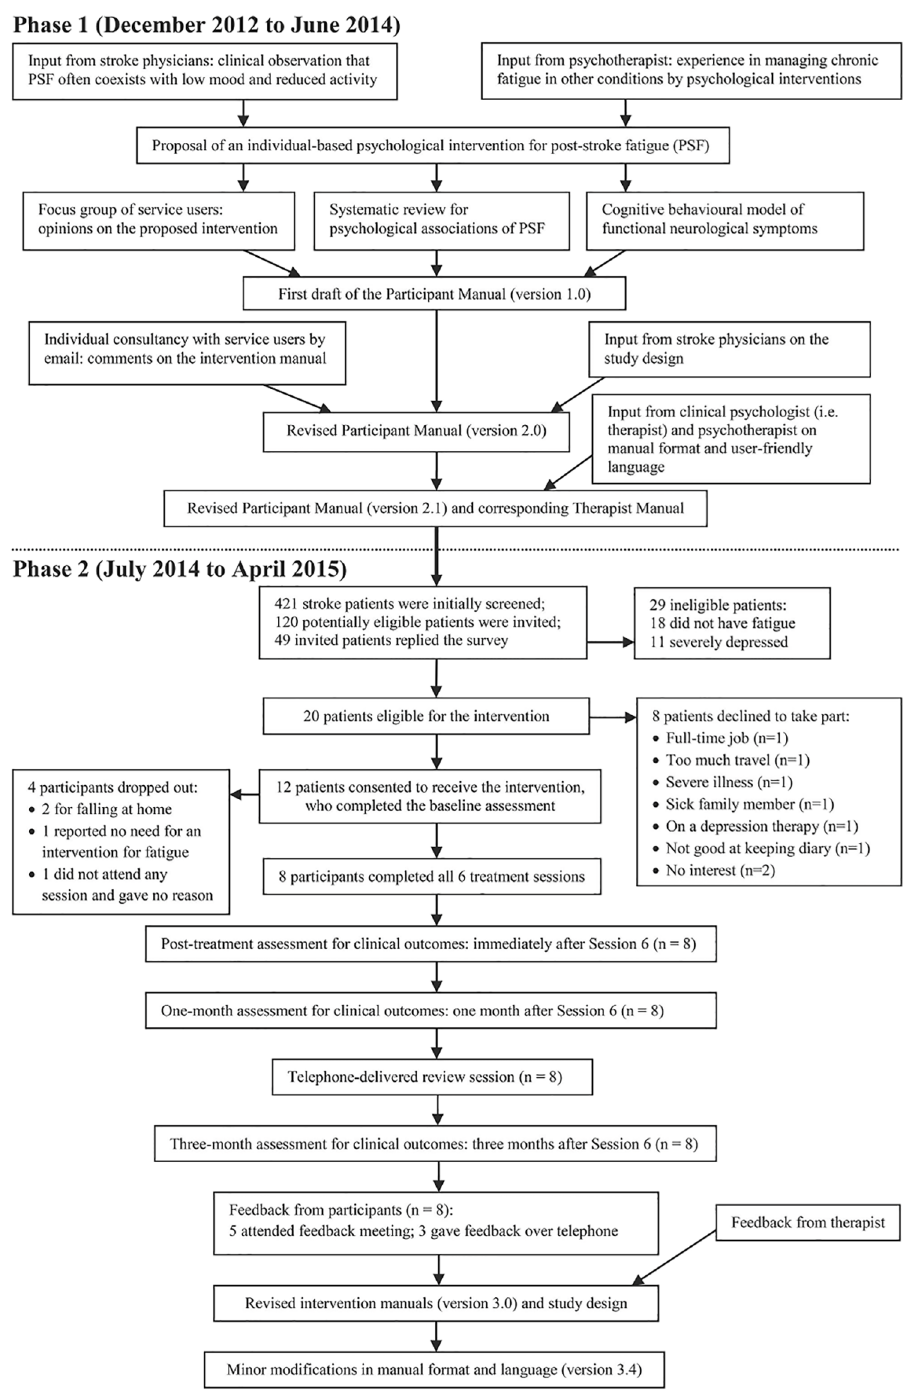
Fig 1. Flowchart of the development and feasibility study of a psychological intervention for post- stroke fatigue.